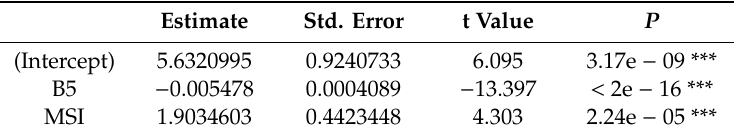
Table 5. Coe ffi cient of the MLR Table 5. Coefficient of the MLR model.